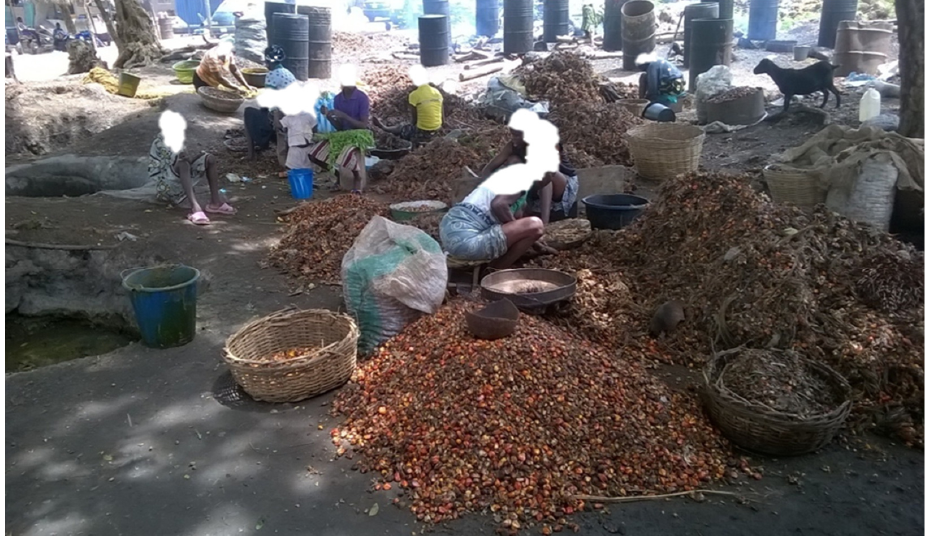
Figure 1. Processing of palm fruit in the local refinery from where POME was collected